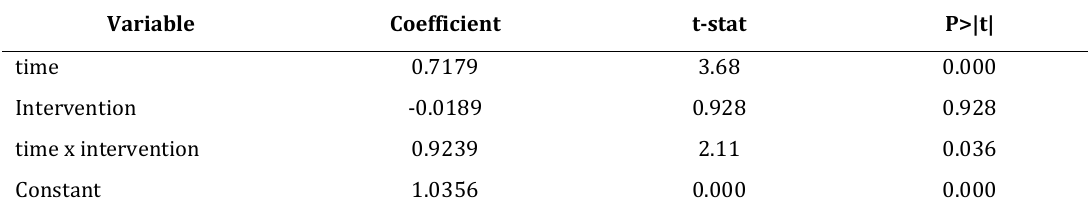
Table 7: The impact of EU entrance in the EU in terms of FDI compared to OECD countries that are not in the EU Variable